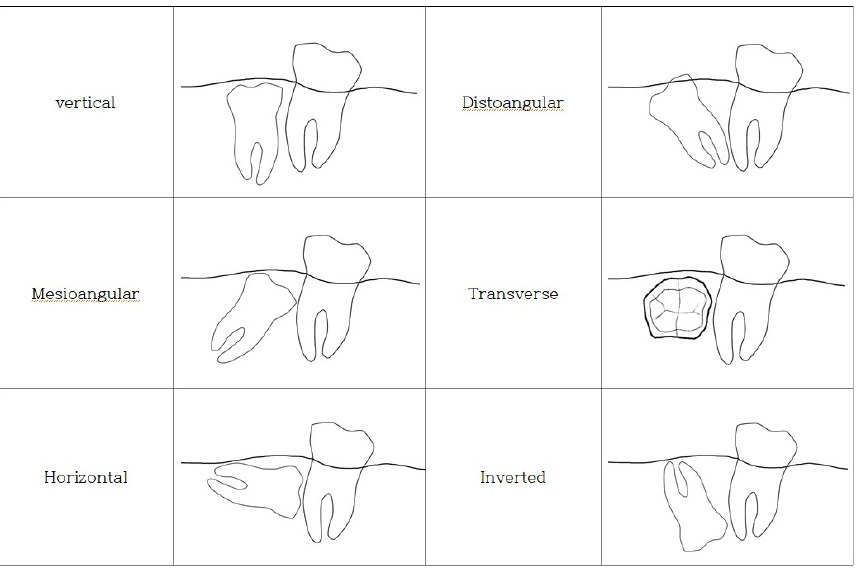
Figure 1. Pell and Gregory classification: ( A ) Class A, ( B ) Class B, ( C ) Class C, ( D ) Class I, ( E ) Class II, and ( F ) Class III.